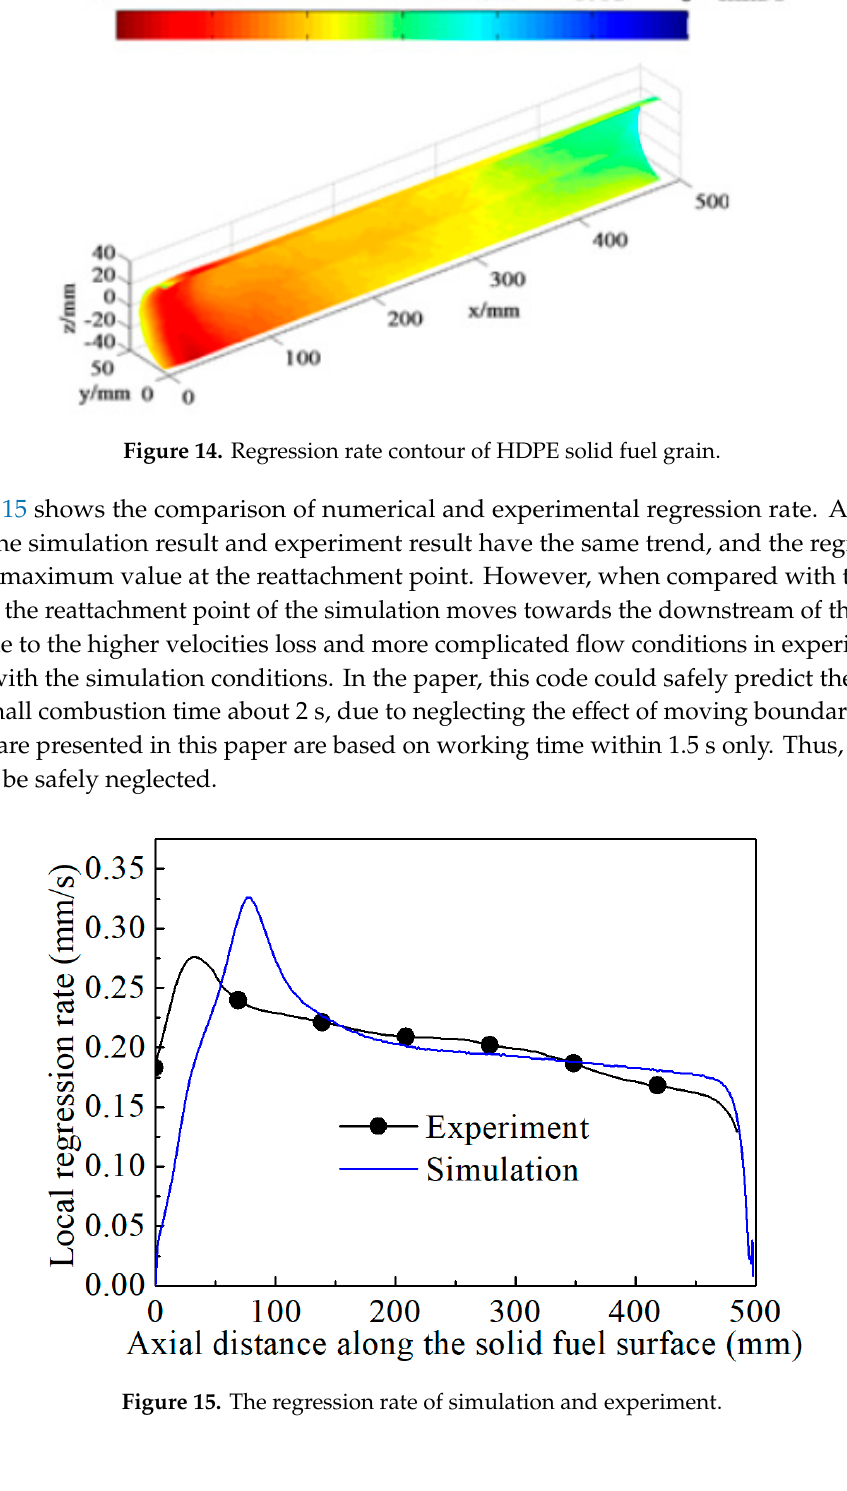
Figure 13. Internal surface of solid fuel after combustion.